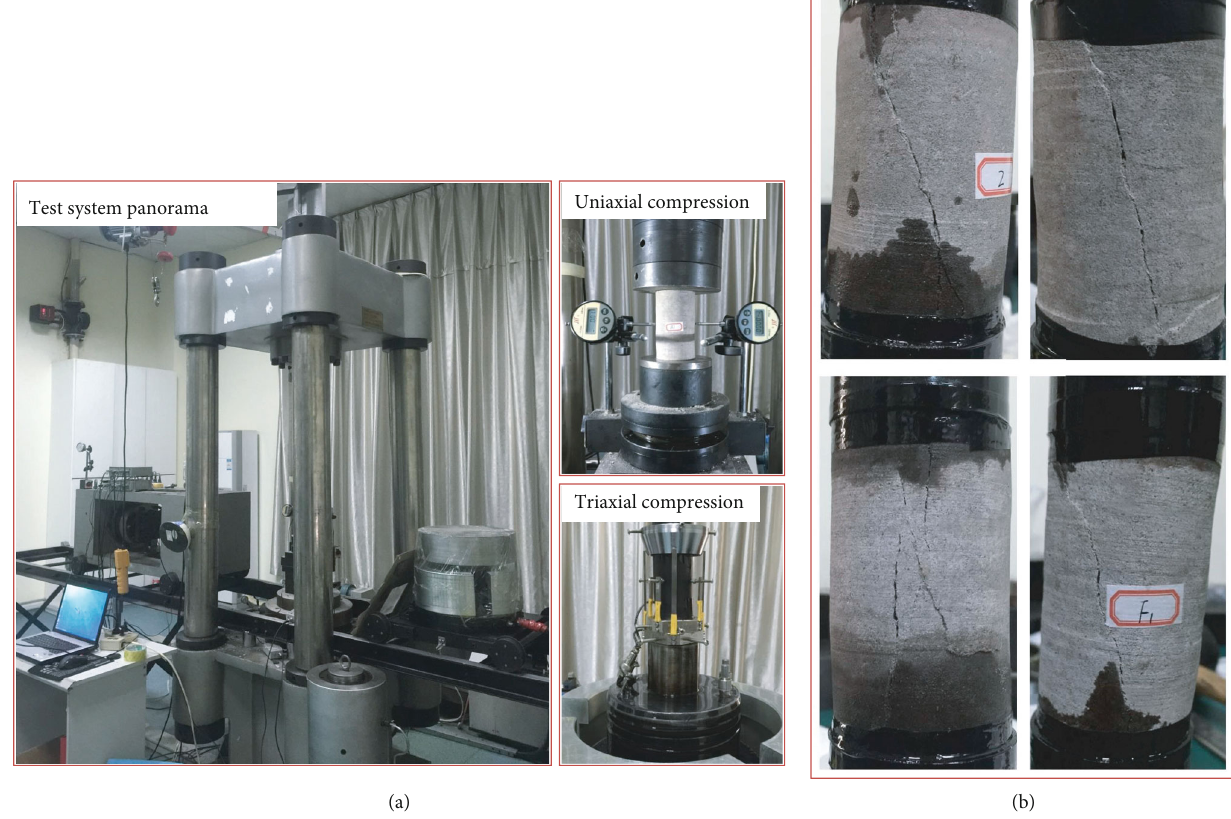
Figure 2: (a) Test system and (b) failure form of sandstone samples. Table 1: Mechanical properties of